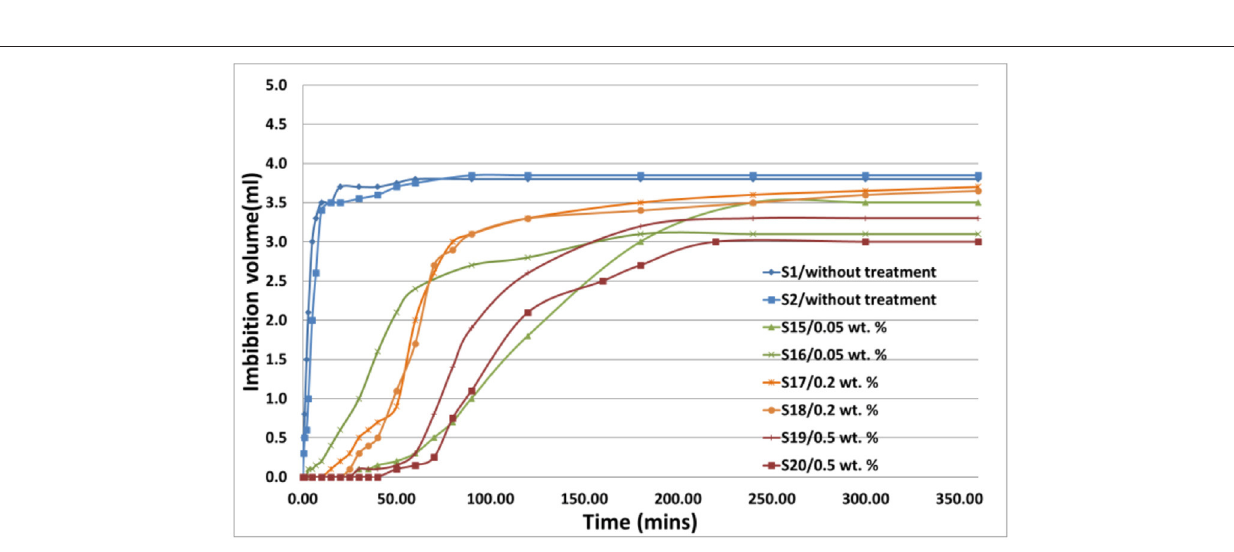
Frontiers in Physics |